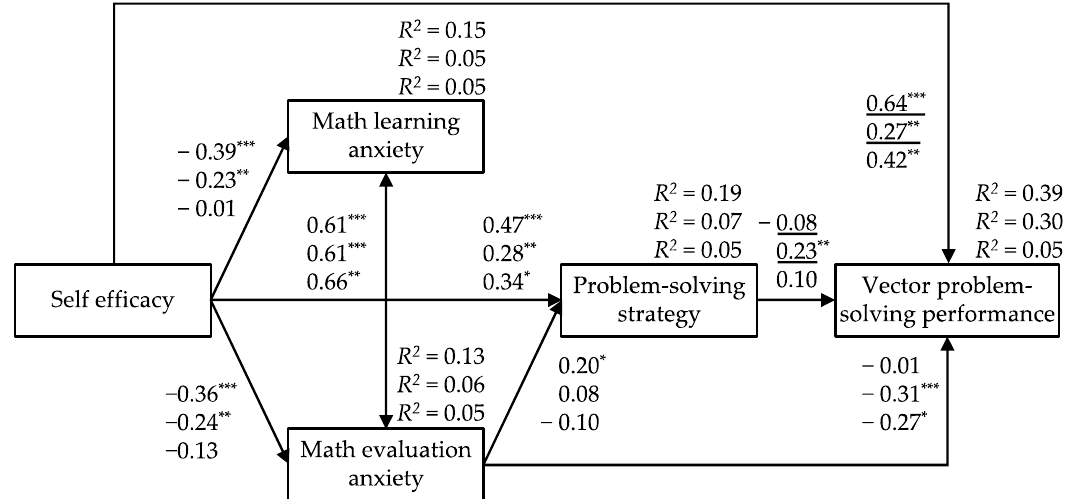
Figure 3. Results of the multiple group structural equation modelling. The top row represents the standardised path coefficients for High and Stable , the middle row for Medium and Unstable and the bottom row for Low and Unstable . The results of the difference in path coefficients test underlined those showing significant differences. *** p < 0.001, ** p < 0.01, * p < 0.05.